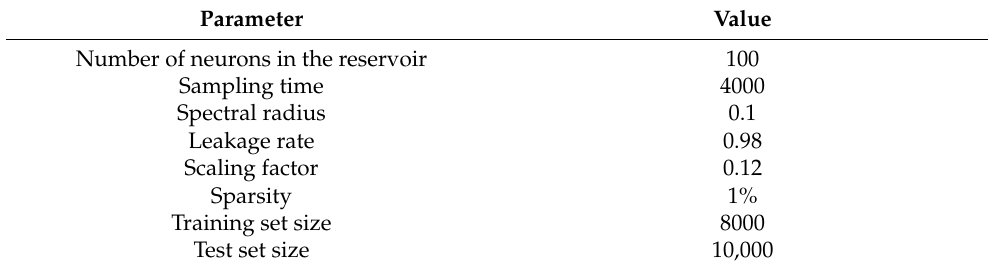
Table 2. Parameters of PA-RC.